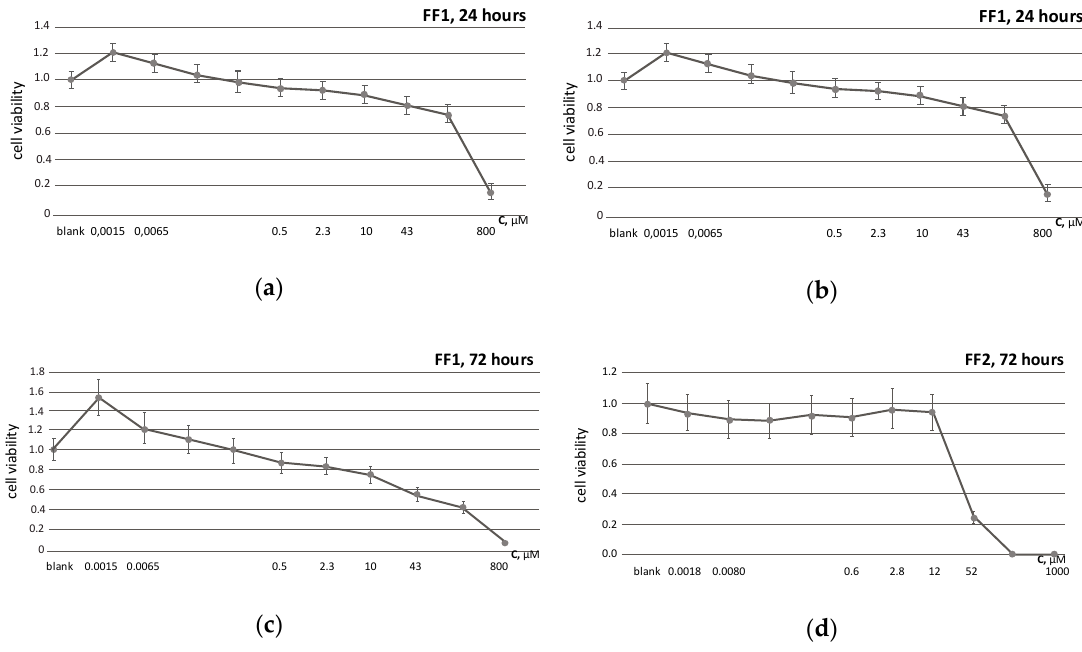
Figure 3. The 3-(4,5-dimethylthiazol-2-yl)-2,5-diphenyltetrazolium bromide (MTT) test: cell viability versus concentrations of FF1 in ( a ) 24 h and ( c ) 72 h; FF2 in ( b ) 24 h and ( d ) 72 h of incubation. In blank experiments, cells were incubated without the